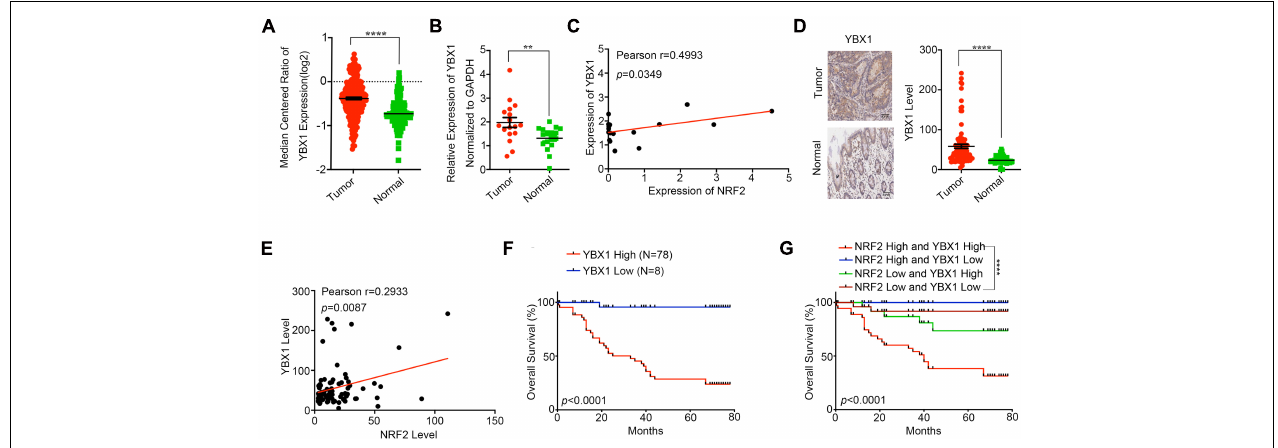
FIGURE 6 | YBX1 is highly expressed in CRC and associated with poor prognosis. (A) YBX1 expression in CRC tissues and adjacent normal tissues was investigated in Oncomine database. (B) YBX1 mRNA expression in CRC tissues and paired adjacent normal tissues was identified by qRT-PCR. (C) Regulation analysis of the correlation between YBX1 and NRF2. Each point represents one cancer sample. (D) Representative immunohistochemical staining and expression level statistics of YBX1 in CRC tissues and paired adjacent normal tissues. (E) Regulation analysis of the correlation between YBX1 and NRF2. Each point represents one cancer sample. (F) Kaplan–Meier analysis of the overall survival of CRC patients with different YBX1 expression levels ( p < 0.05, log-rank test). (G) Kaplan–Meier analysis of the overall survival of CRC patients with different YBX1 and NRF2 expression levels ( p < 0.05, log-rank test). * p < 0.05;** p < 0.01; *** p < 0.001; **** p < 0.0001; ns, no significance.